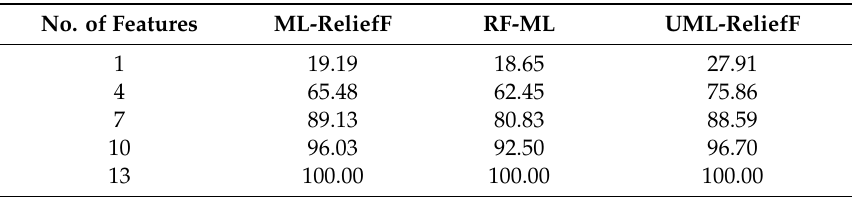
Table 2. Weight concentration of top N features (%).